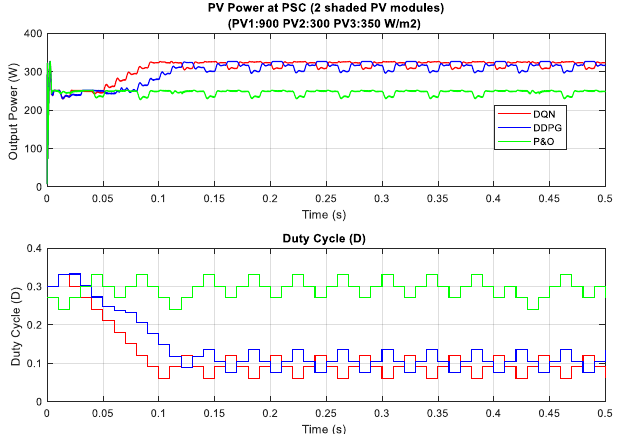
Figure 15. PV power under PSC with two shaded PV modules.